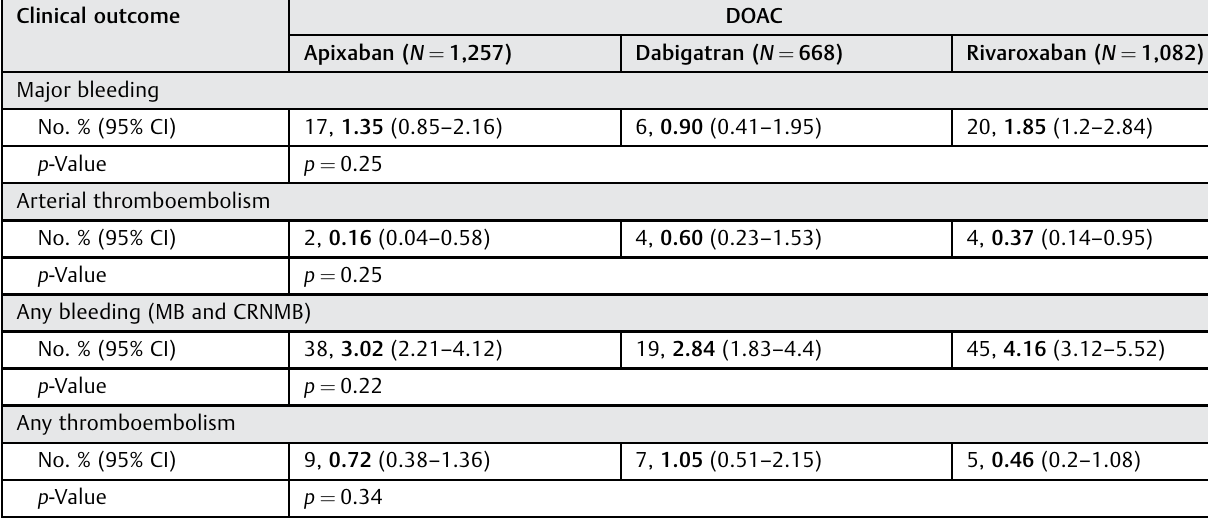
Table 2 Effect of DOAC type of clinical outcomes Clinical outcome